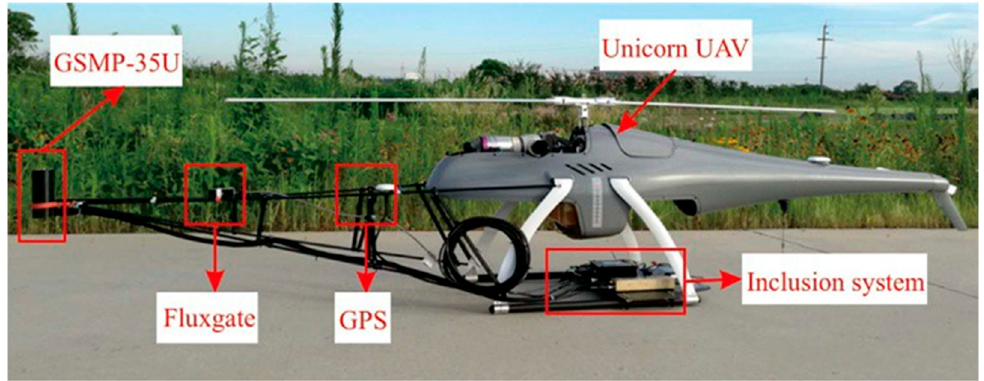
Figure 8. UAV detection platform.